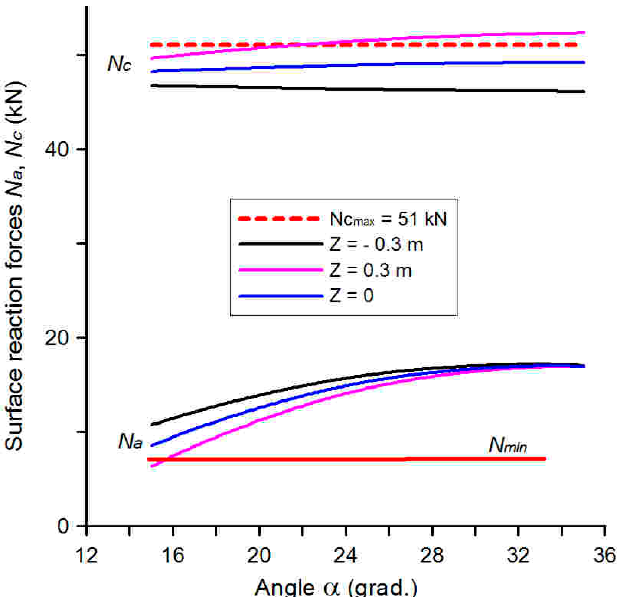
Figure 8. Dependence of forces 𝑁 (cid:3028) and 𝑁 (cid:3030) on the installation angle 𝛼 of the central link of the rear- mounted mechanism of the tractor when installing lower 𝛽 = 10° ( 𝛼 > 𝛽